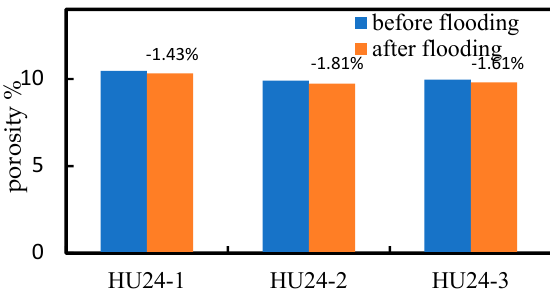
Figure 5. Core porosity before and after the flooding experiments.